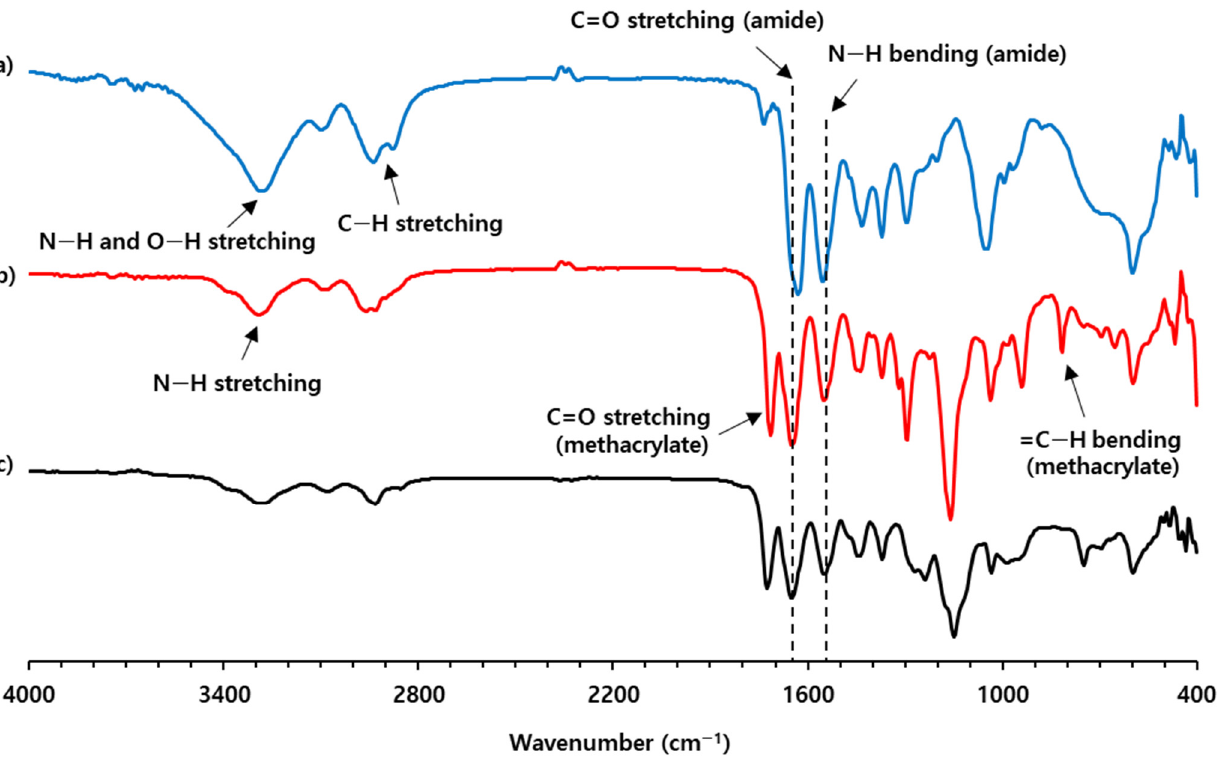
Figure 3. FTIR spectra of ( a ) hydroxyl amide 1, ( b ) Me-am 2, and ( c ) the UV-cured Me-am 2. With this compound in hand, the acrylic polymer (Ac-am 3) containing amide groups was synthesized (Scheme 1) and used to fabricate the h-PSA. To realize the tack property, acrylic monomers with chain lengths of C4 to C8 were used as the main components for synthesizing Ac-am 3. In addition, 2-hydroxyethyl acrylate (HEA) was also employed as a component for the acrylic polymer because strong hydrogen interactions between the hydroxyl groups and the amide groups were expected. Through free-radical polymeriza-